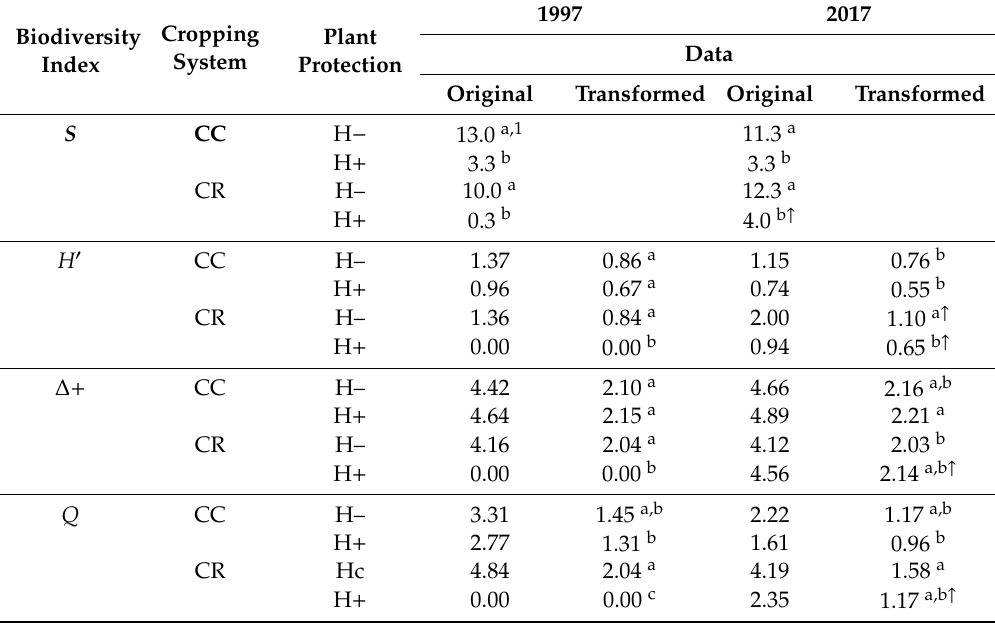
Table 6. Weed biodiversity in winter rye